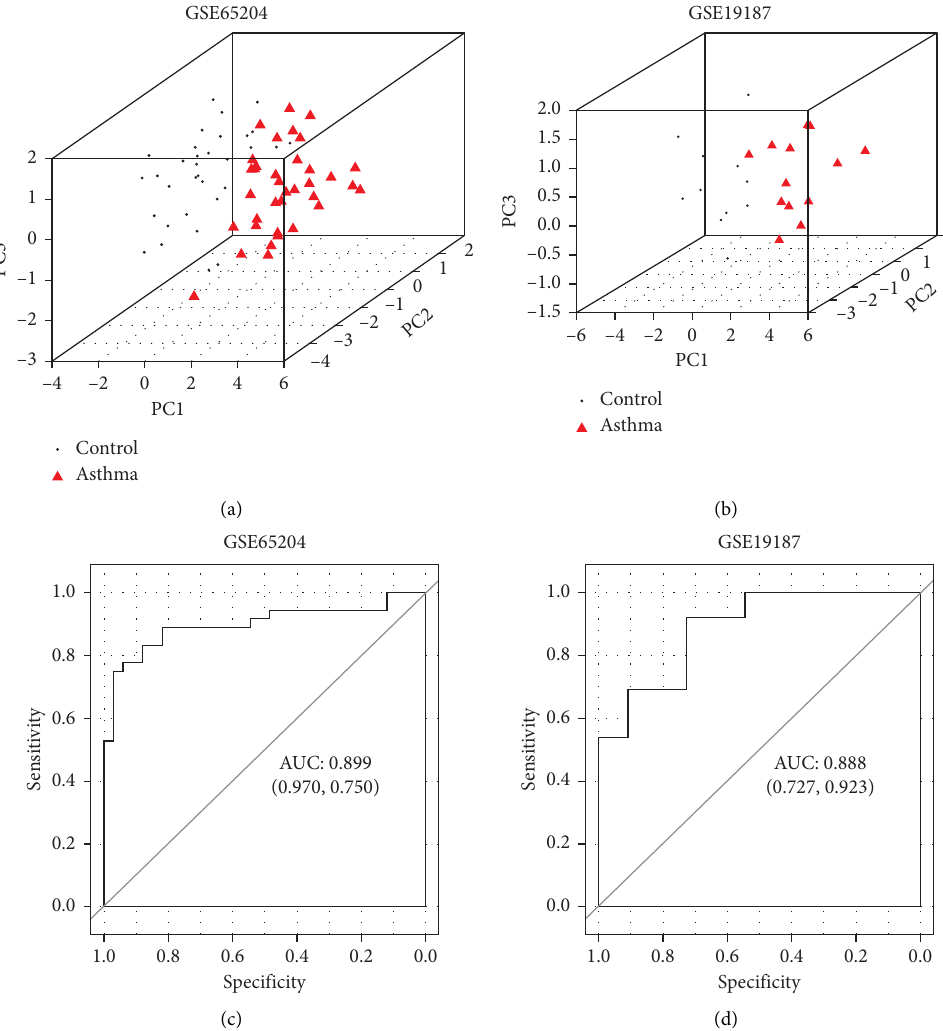
Figure 4: Principal component analysis (PCA) of the identified genes in the coexpression network. Three-dimensional diagrams of the sample distribution based on PC1, PC2, and PC3 in GSE65204 (a) and GSE19187 (b). The black dots represent the healthy samples, and the red triangles represent the asthma samples. The X -, Y -, and Z -axes represent PC1, PC2, and PC3, respectively. Receiver operating characteristic (ROC) curves in GSE65204 (c) and GSE19187 (d). The figures in brackets represent specificity and sensitivity,